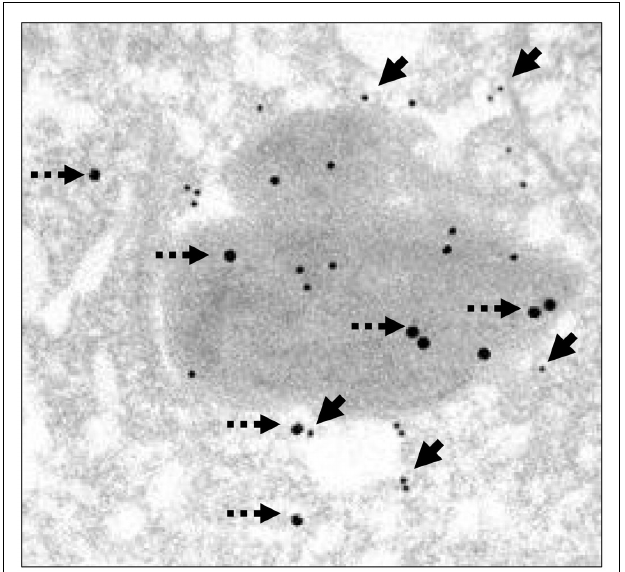
FIGURE 8 | Illustration ofAGS cells with intracellular H. pylori WT with H. pylori andVacA immunogold. AGS cell infected using a dual pre-embedding immunogold ( H. pylori gold 18nm andVacA-gold 11nm) demonstrating the presence of 18nm H. pylori gold particles (dashed arrow) and 11nmVacA-gold particles in cytoplasm, in the cell membrane, in membrane vesicles, and in the AGS cell. Original magnification 71,000 × .